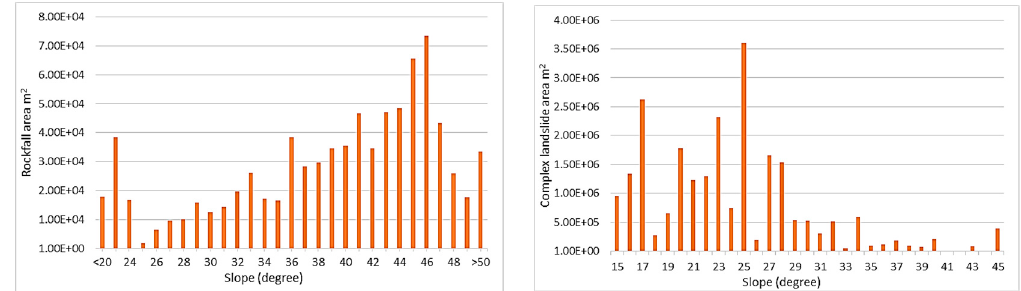
Figure 10. Histograms of the relationship between landslide area slope degrees.